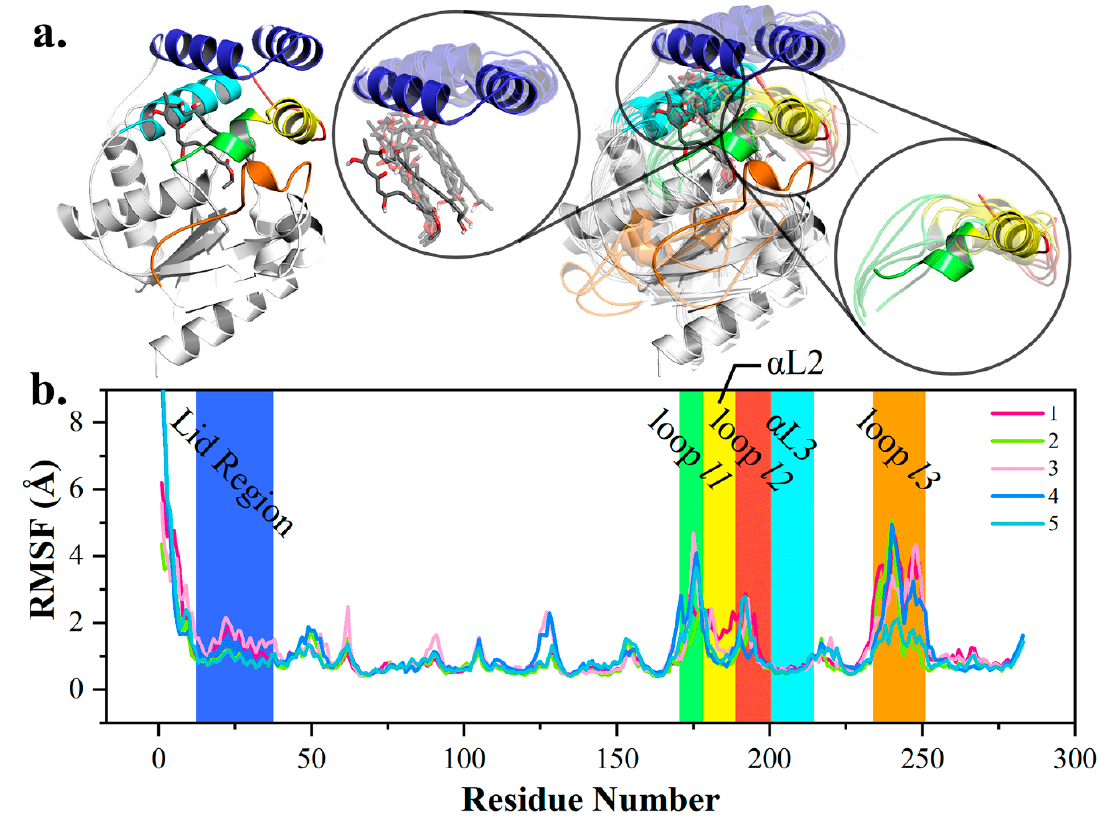
Figure 2. Conformational change of pima-TE system during molecular dynamics (MD) simulations. ( a ) Structural variations between post (opaque) and pre-simulation (transparent) complexes, with lid region, polyketide chain, α -helix α L2, α L3 and loop l1 , l2 & l3 colored in tv_blue, gray, yellow, cyan, green, red and orange. ( b ) Root-mean-squared fluctuation (RMSF) of five trajectories with key structural elements highlighted.